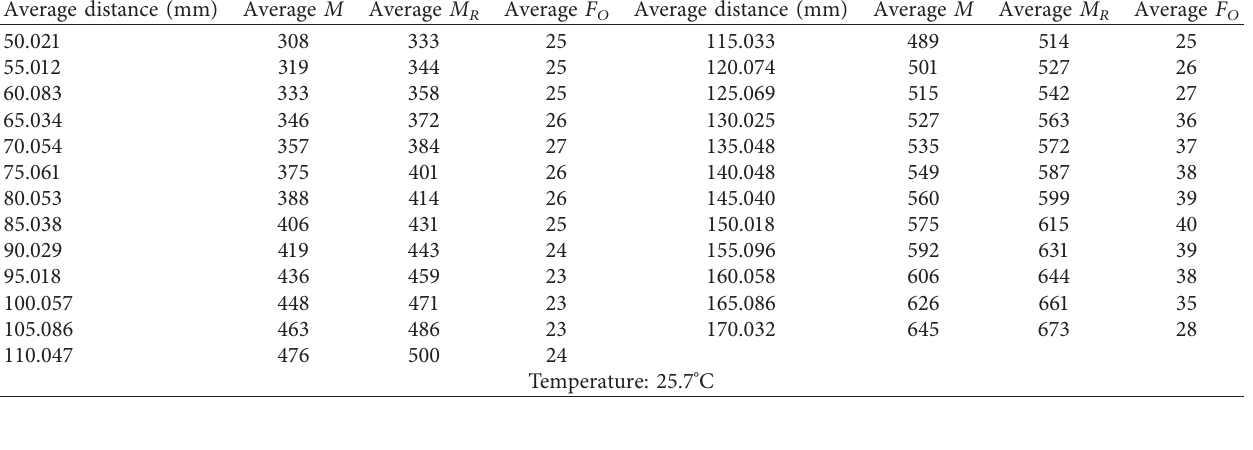
Table 1: Average fixed distance and the two average feature points.